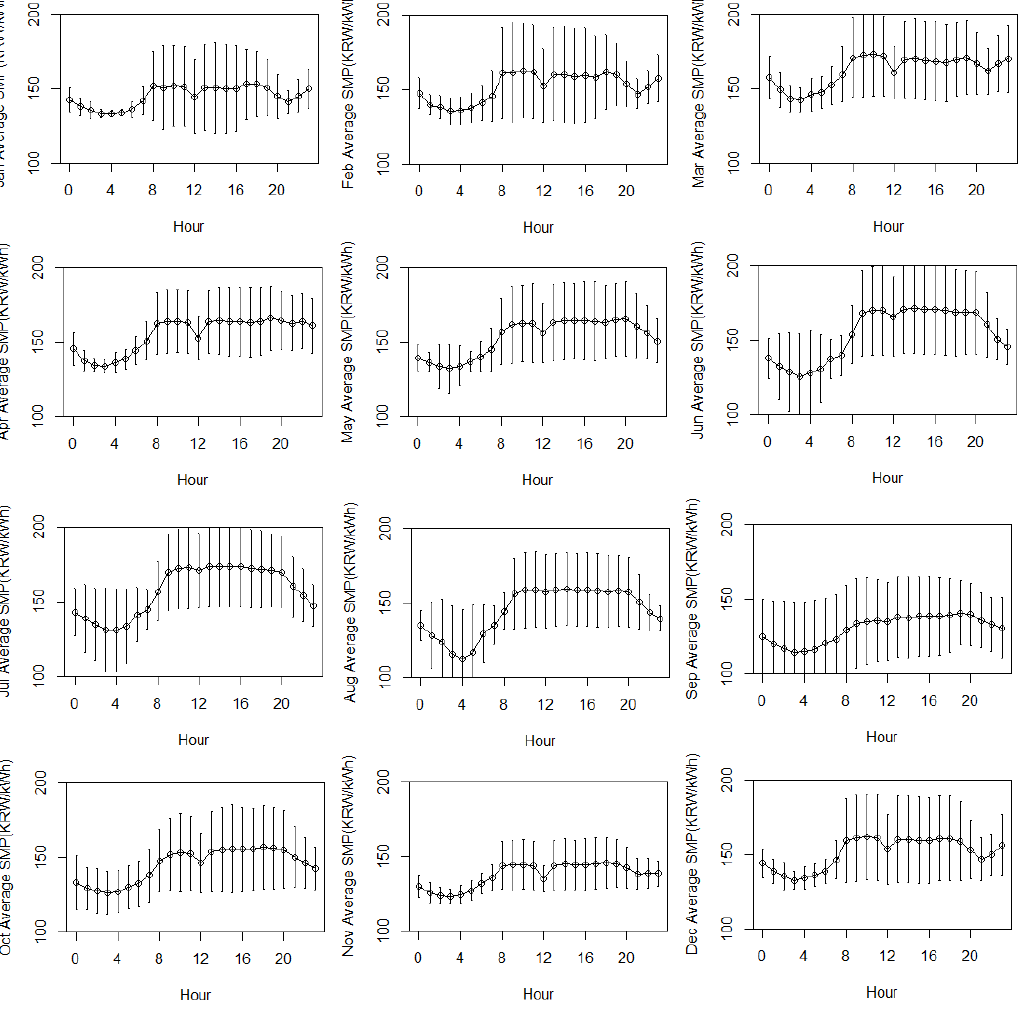
Figure 7. Estimated sample mean and one standard deviation range of SMPs at each hour on each month based on 3-year historical data in the Korean electric power